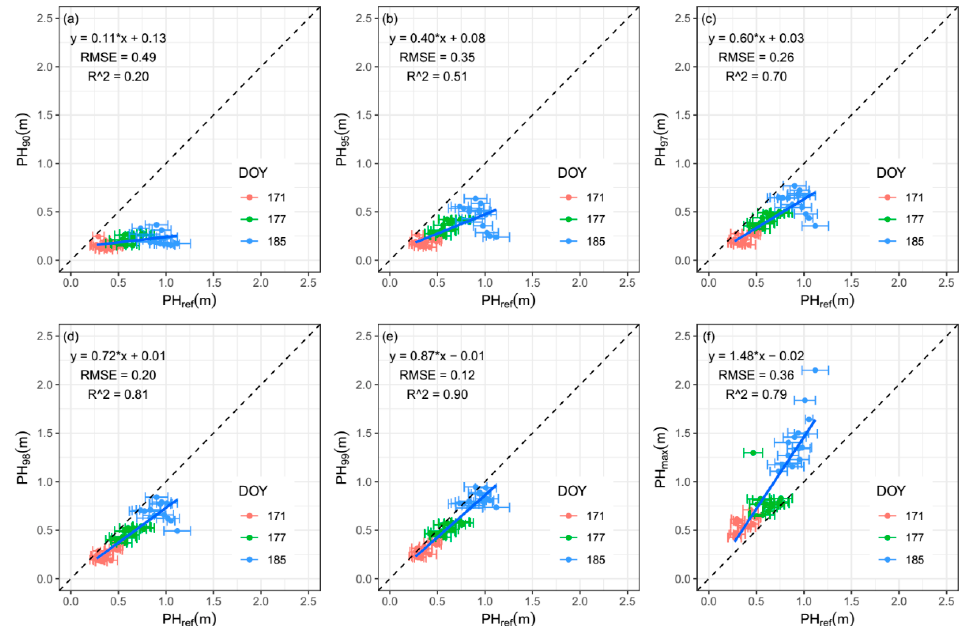
Figure 6. Correlations between maize plant heights derived from UAV RGB point clouds and ground-truth plant heights (PH ref ). Maize plant height estimations were obtained by using the 90th ( a ); 95th ( b ); 97th ( c ); 98th ( d ); and 99th ( e ) percentiles; and maximum value ( f ) of point clouds altitude to represent the plant level, respectively. R 2 represents the coefficient of determination and RMSE represents the root mean square error.